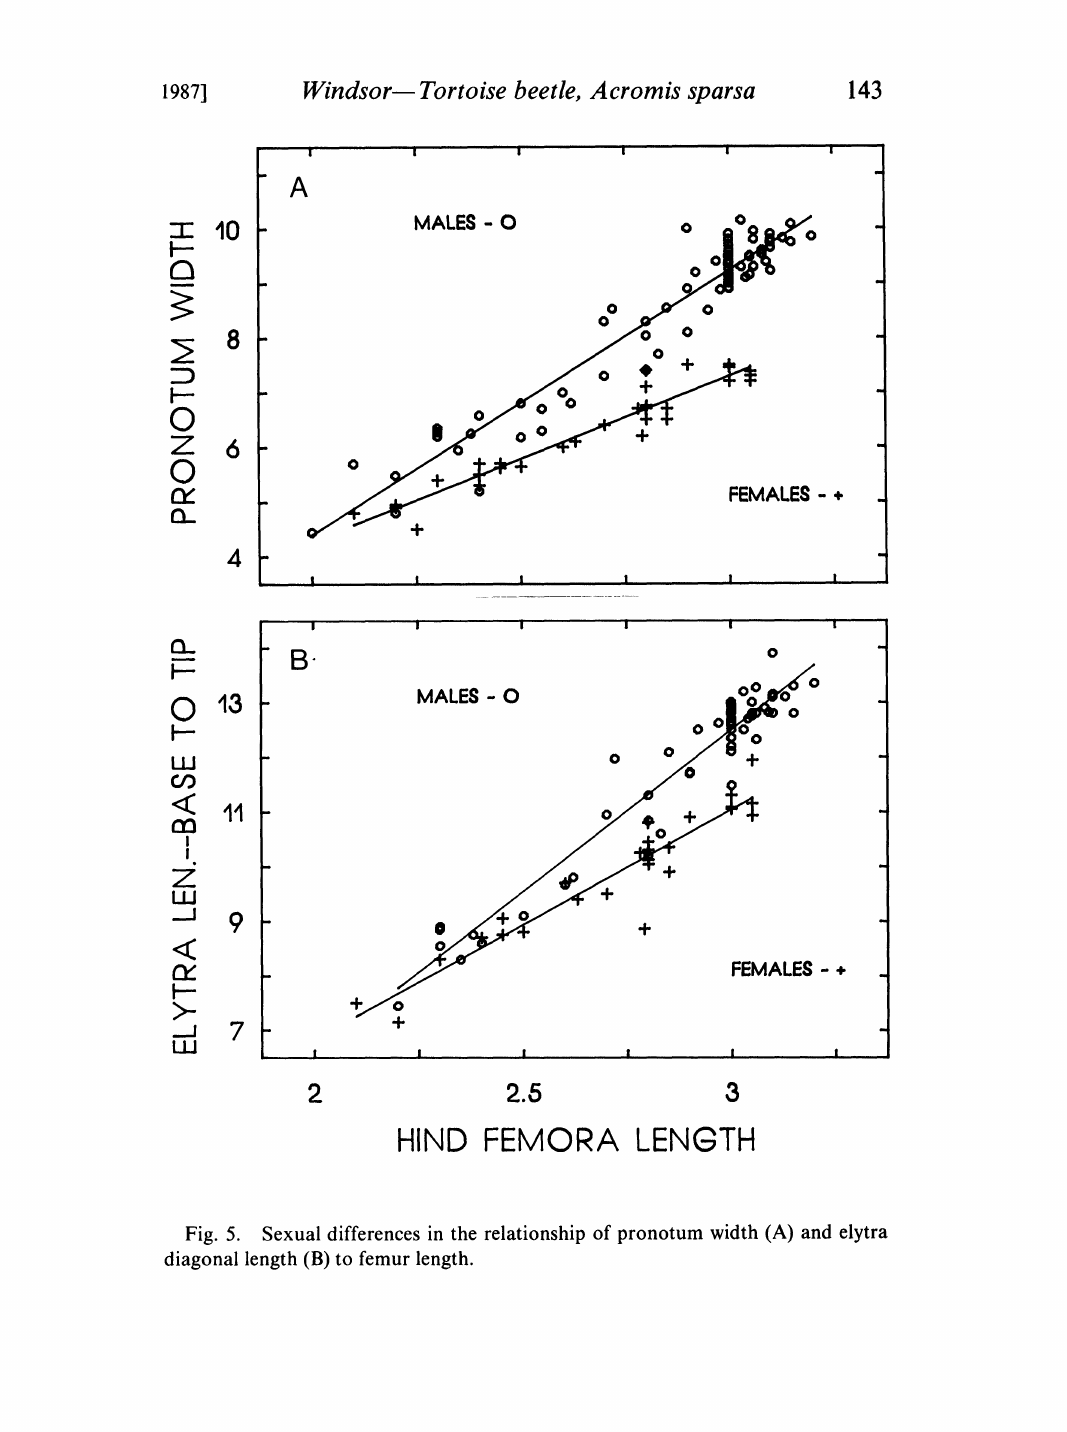
Fig. 5. Sexual differences in the relationship of pronotum width (A) and elytra diagonal length (B) to femur